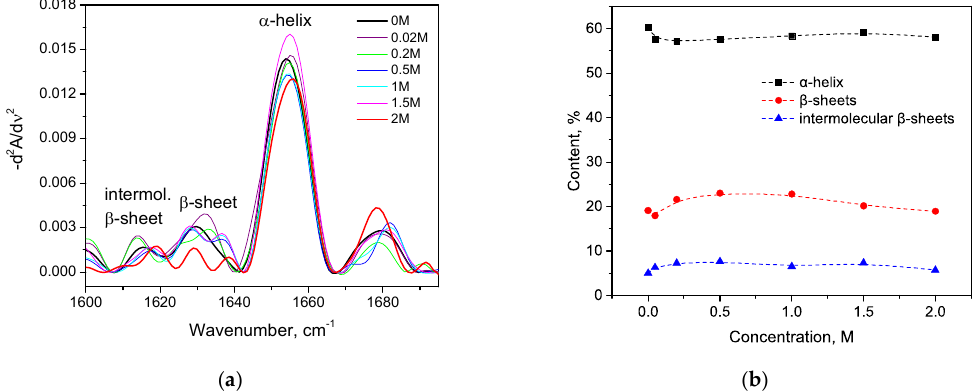
Figure 9. Changes in the second derivative of the Amide I band ( a ) and in secondary structure ( b ) of HSA in 10% wt. aqueous solution at 23 °C with various concentrations of (NH 4 ) 2 SO 4 . Ammonium sulfate also stabilizes the trypsin structure. Figure 10a shows that with the increase of (NH 4 ) 2 SO 4 concentration there is no shift to smaller wavenumbers. The percentage of intermolecular β-sheets of trypsin significantly decreases while the contents of β-sheets (Figure 10b) and α-helices remains almost the same.